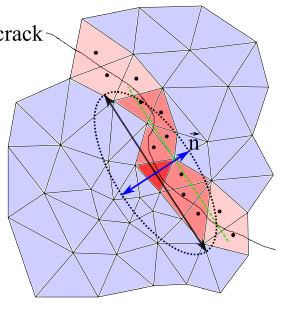
Figure 11. Crack triangle (bright red) and its second order neighbors (red), non-extended triangles (blue), second principal component direction (blue arrows), fitted line (green) Each neighbor triangle center j , that is used for the PCA of trian- gle i , gets a Gaussian weight ω (cid:48) ij that penalizes greater distances: